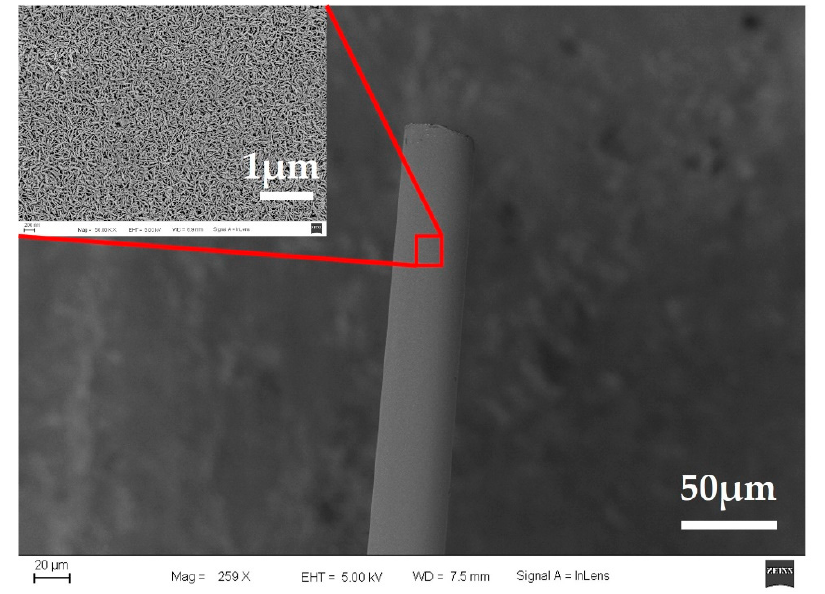
Figure 7. The morphology of an iridium oxide microelectrode under the following parameters: 10 sccm O 2 , 10 sccm Ar, and 15 min of sputtering time.